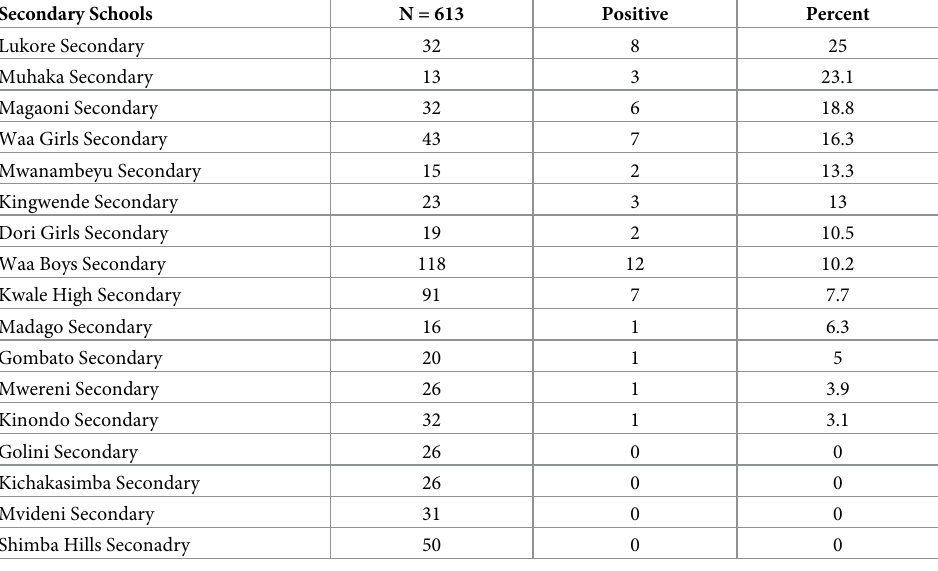
Table 2. Distribution of HBsAg positivity among secondary schools at KSBTC, January 2020-June 2021 (n =